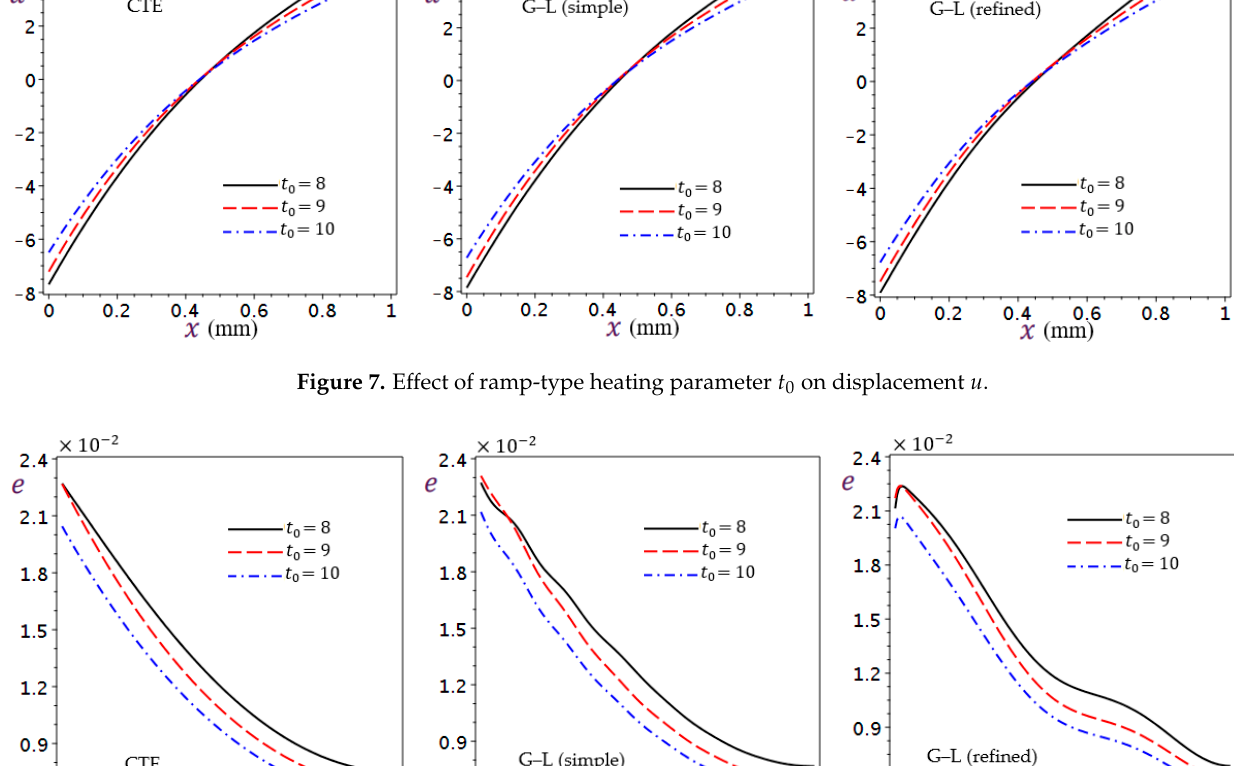
0 on normal stress σ